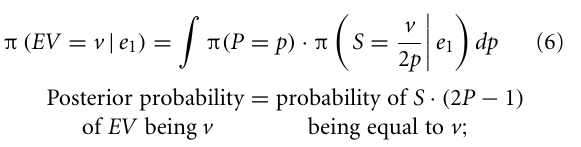
Evolution of expectations about an option while acquiring information